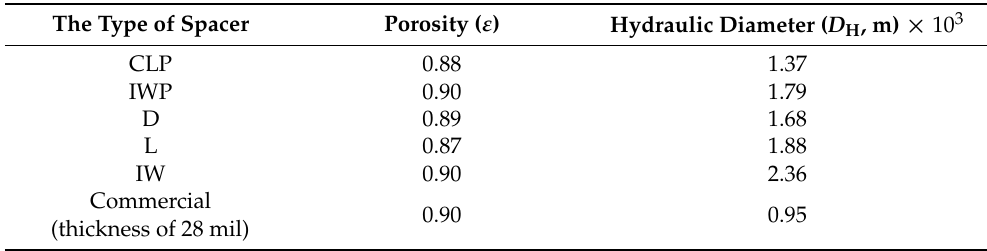
Table 1. Porosity and hydraulic diameter of the computational domains formed by CLP, IWP, D, L, and IW and commercial